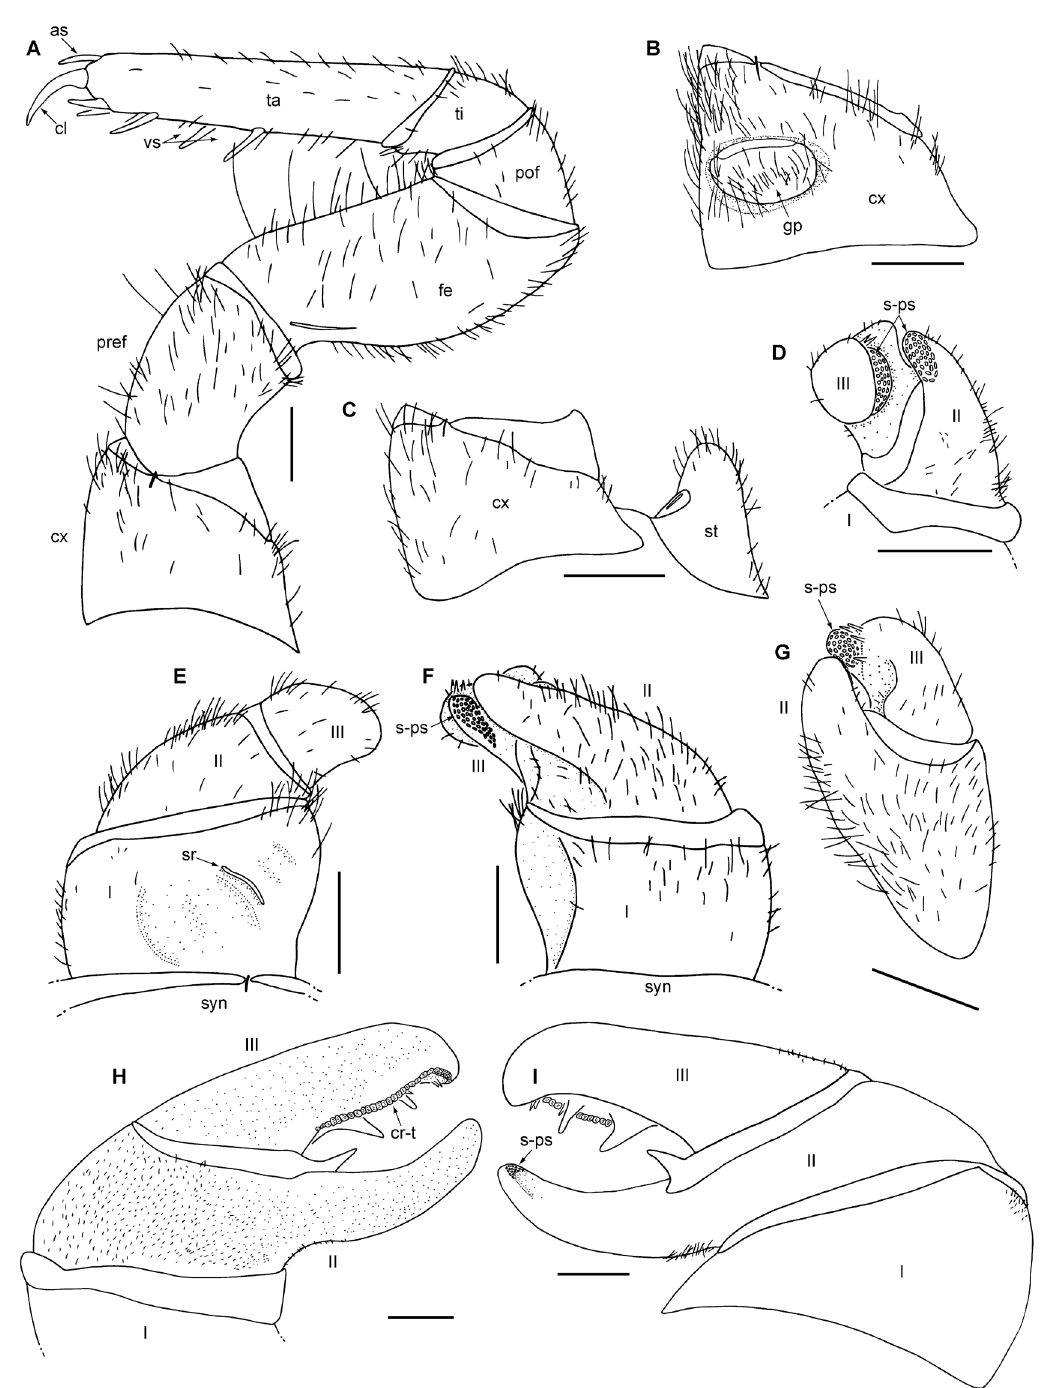
Fig. 4. Zoosphaerium nigrum sp. nov., holotype (CASENT 9068289). A . Left leg 9, posterior view. B . Left coxa 2 with gonopore, posterior view. C . Left coxa 1 with stigmatic plate, posterior view. D . Left anterior gonopod, mesal view. E . Left anterior gonopod, anterior view. F . Left anterior gonopod, posterior view. G . Left anterior gonopod, lateral view. H . Right posterior telopod, posterior view. I . Right posterior telopod, anterior view. Abbreviations: as = apical spine; cl = claw; cr-t = crenulated teeth; cx = coxa; fe = femur; gp = gonopore; pof = postfemur; pref = prefemur; s-ps = sclerotized spots; sr = stridulation rib; st = stigmatic plate; syn = syncoxite; ta = tarsus; ti = tibia; vs = ventral spines. Roman numerals indicate telopoditomeres. Scale bars = 1